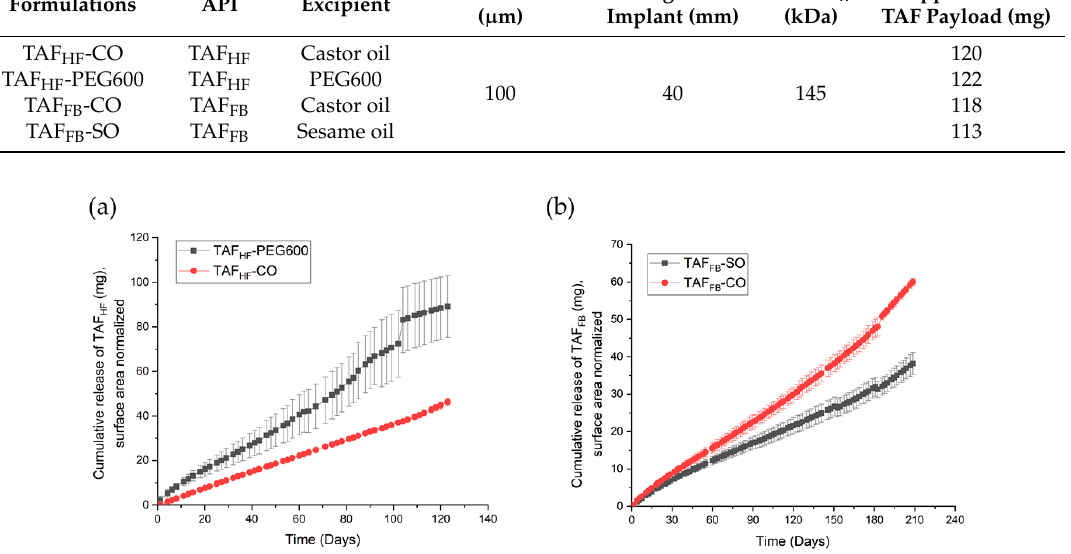
Figure 2. Cumulative release profiles of various TAF HF ( a ) and TAF FB ( b ) formulations.